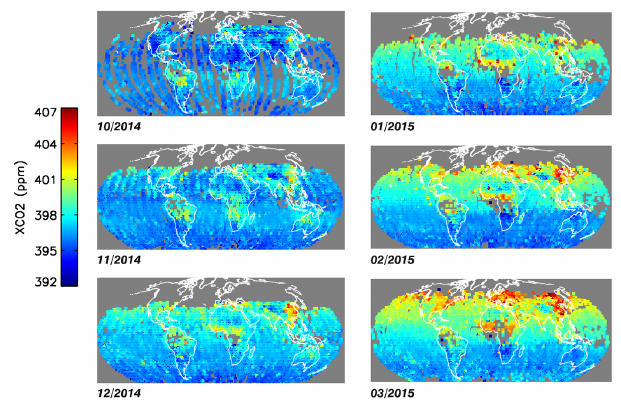
Figure 3. Maps of total column dry air ratio of CO 2 (X CO OCO-2 from October 2014 through March 2015. Data have been bias corrected and screened using the data quality flag in the Lite file and averaged in 2 ◦ by 2 ◦ bins.